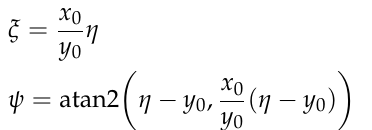
) and orange ( ψ = − π ) 2 2